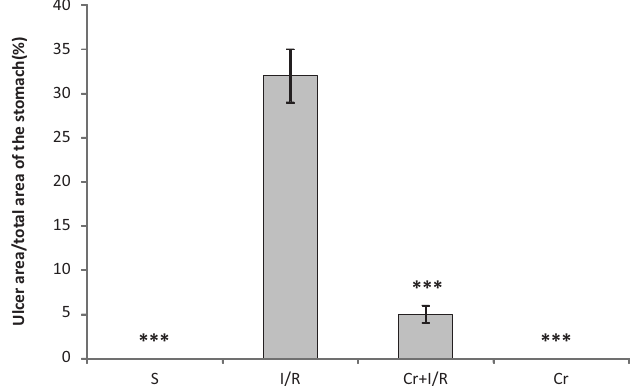
FIGURE 2 - The calculated ulcer index in S: sham-operated group, I/R: I/R injury animals, Cr+I/R: rats pretreated with crocin (15 mg/kg, i.p.) 30 min before intervention, Cr: crocin alone group (intact animals that received crocin at 15 mg/kg, i.p.). ***P<0.01 relative to I/R injury group. Data are expressed as mean±S.E.M.